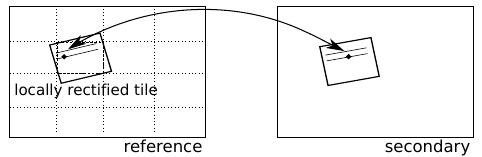
Figure 9: A match on a rectified tile is interpreted as a point cor- respondence in the coordinate systems of the original images.